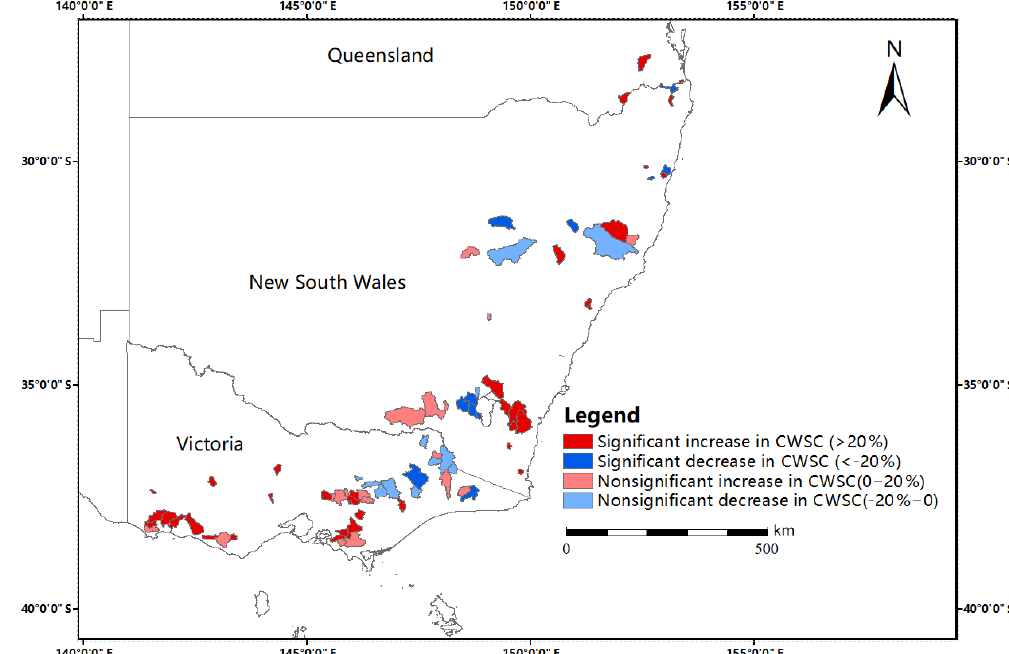
Figure 4. Location map of the catchments with significant and nonsignificant shifts in the CWSC. The red (blue) color denotes the catchments that have a significant increase (decrease) in the CWSC after the change point, while the (light-blue) light-red color denotes the catchments with a nonsignificant increase (decrease) in the CWSC.